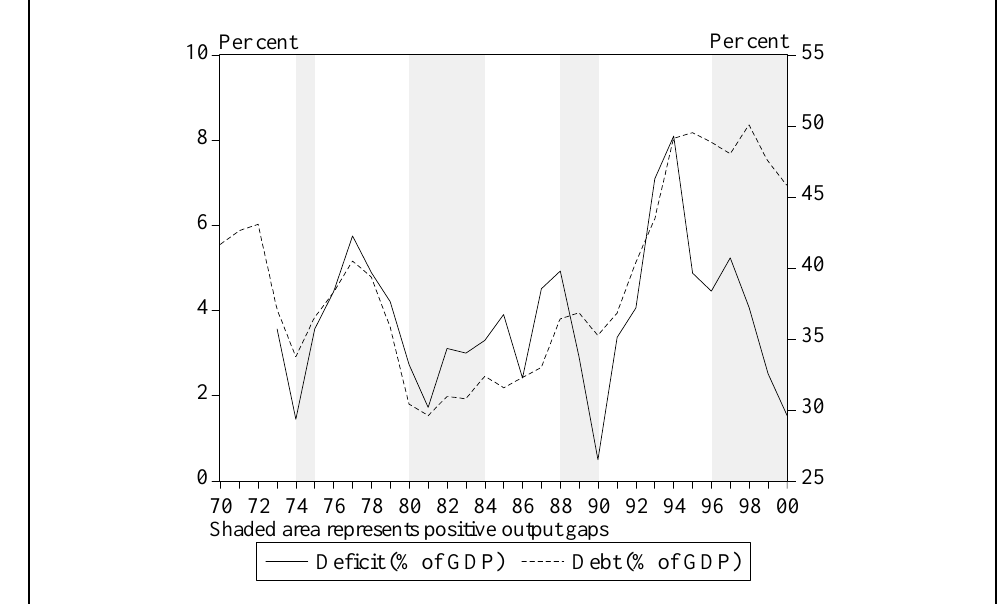
Figure 1 Deficit and debt during positive and negative output gaps